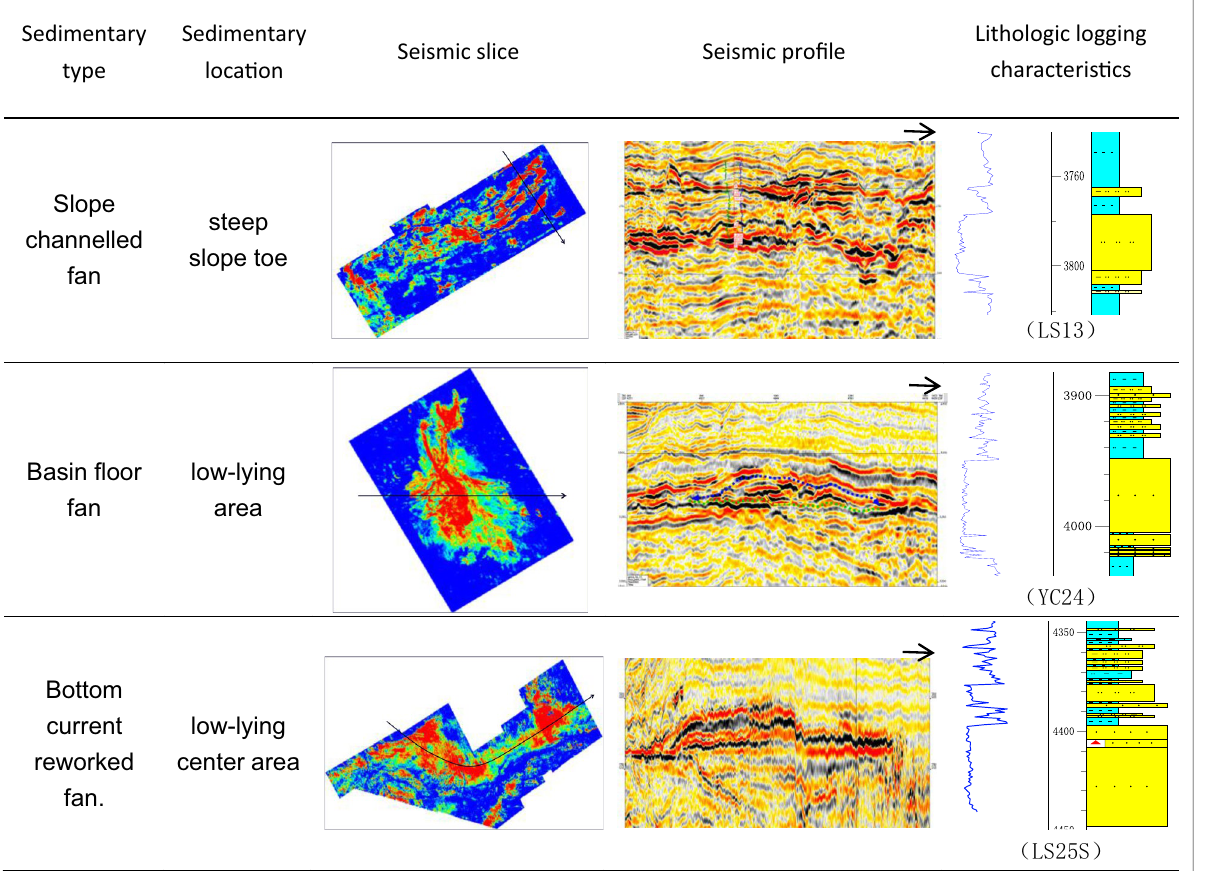
Fig. 6 Characteristics of submarines fans of the Meishan Formation in the Qiongdongnan